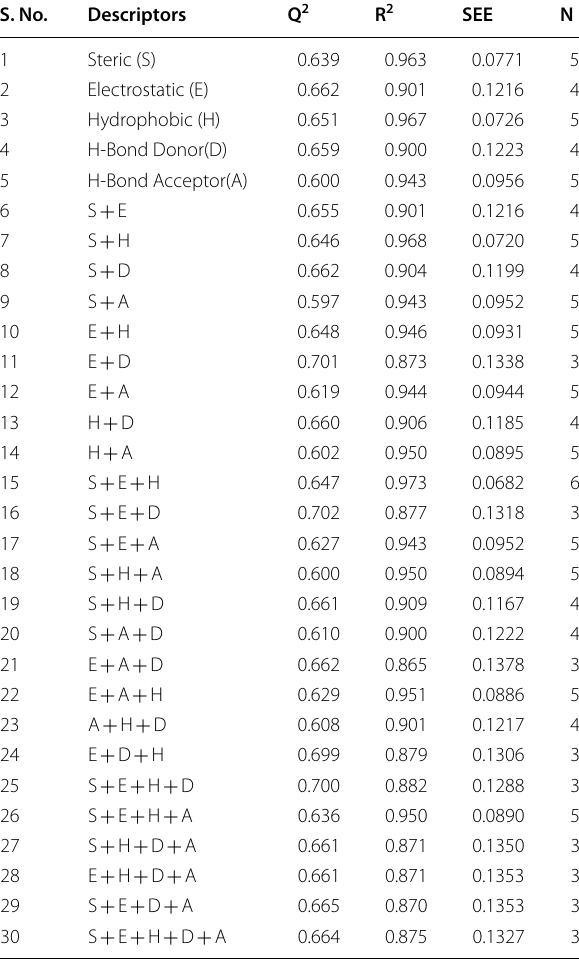
Table 11 Statistical validation results of the best 3D-QSAR models